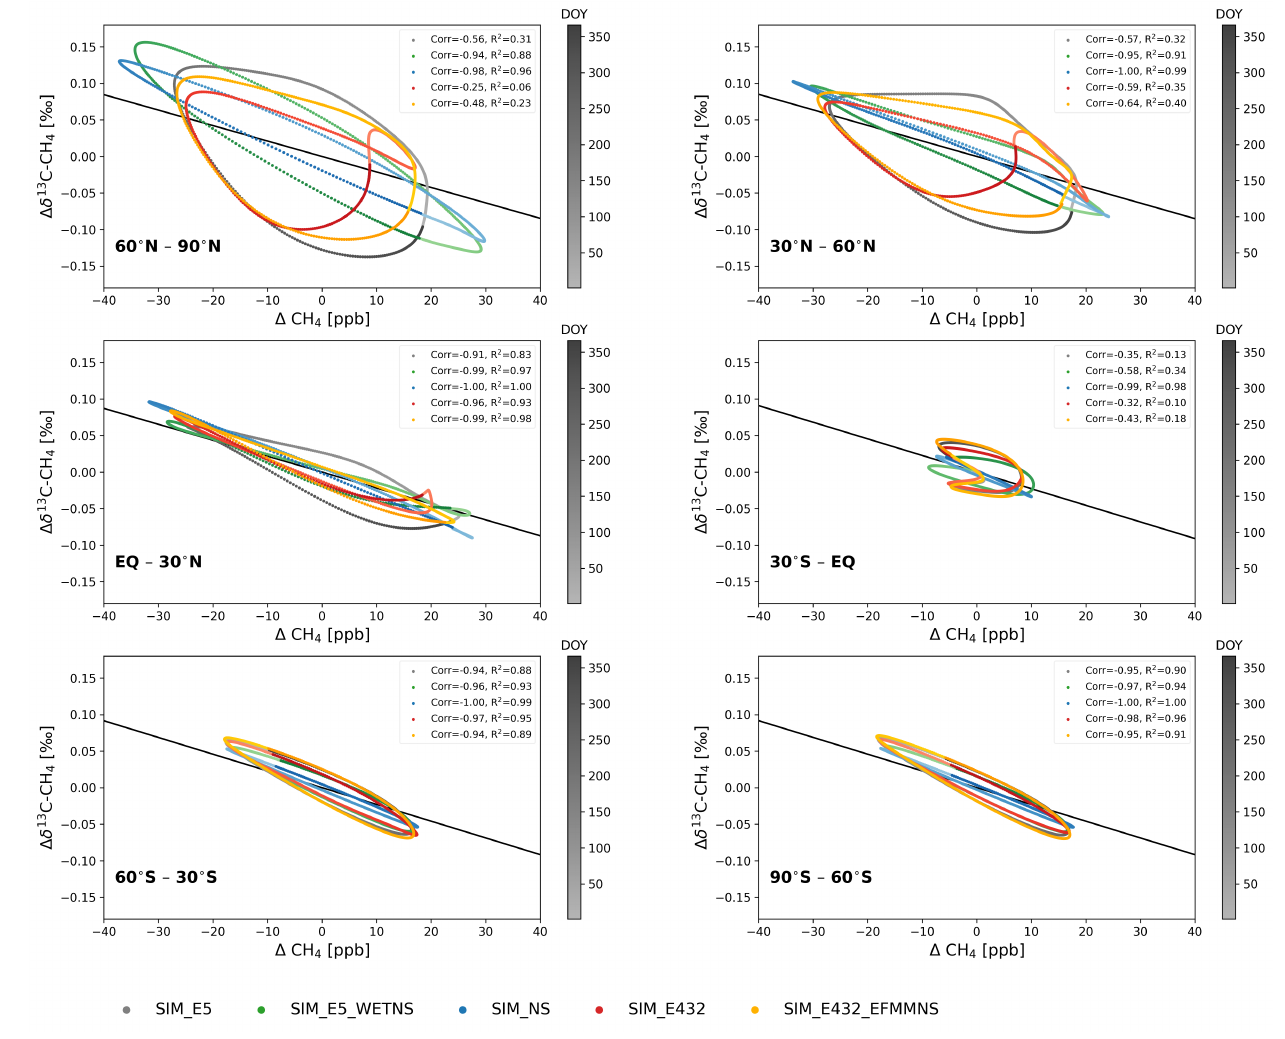
Figure 3. De-trended daily average CH 4 against 𝛿 13 C from the lowest five levels over 2002–2012 at 30° latitudinal bands. Color schemes indicate different simulations, and the color darkness illustrates day of year (DOY). The lightest colors are DOY = 1 and the darkest DOY = 366. The solid black line is the theoretical KIE line of SIM_NS when only the OH sink is